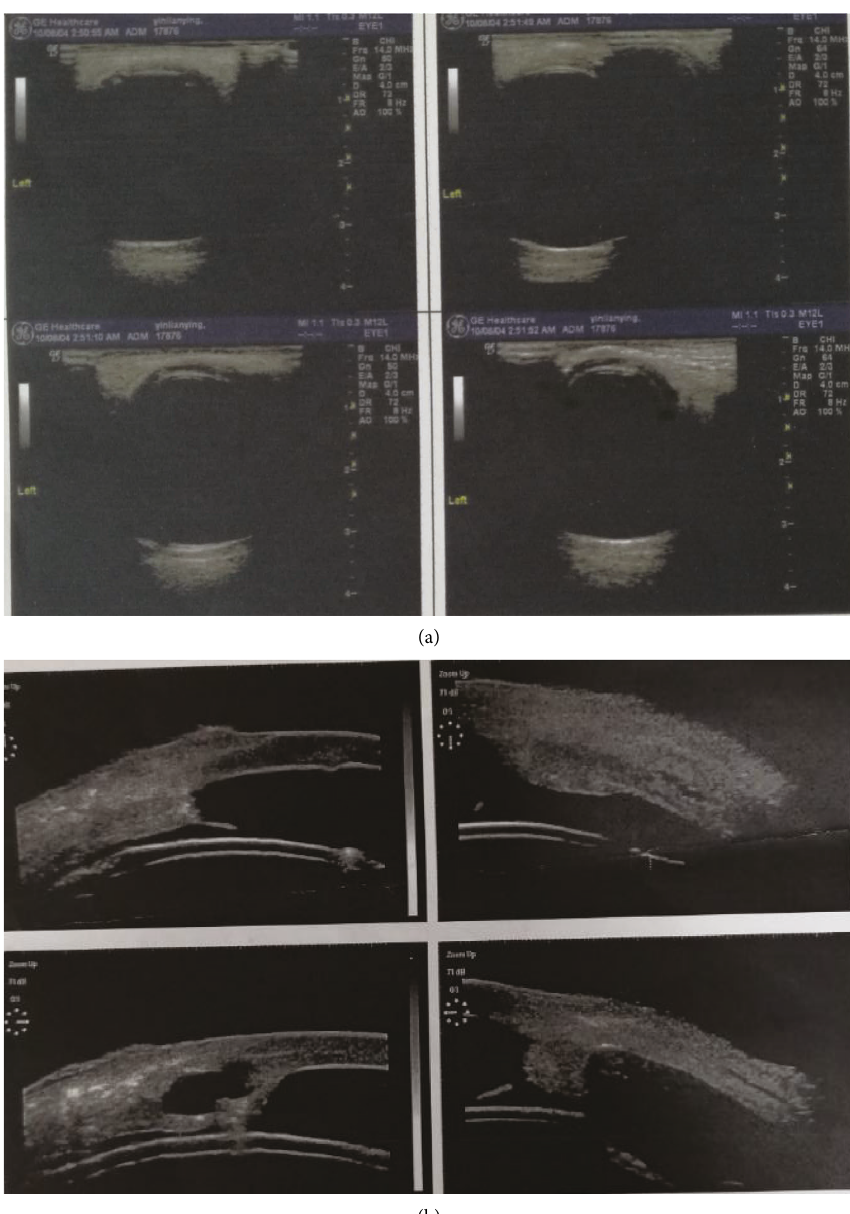
Figure 2: (a): Color Doppler ultrasonography of a patient 6 months after FCVB implantation. (b): Ultrasound biomicroscopy of a patient 6 months after FCVB